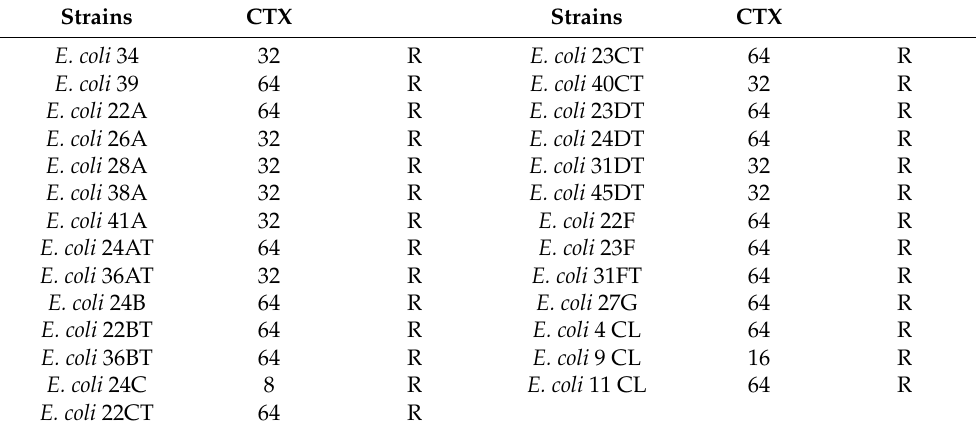
Table 2. Minimum inhibitory concentration (MIC) of cefotaxime (mcg mL − 1 ) against extended- spectrum β -lactamase (ESBL)-producing E. coli strains. Abbreviations for antibiotic: CTX, cefotaxime. Abbreviations for interpretations: S = sensitive; I = intermediate; R =